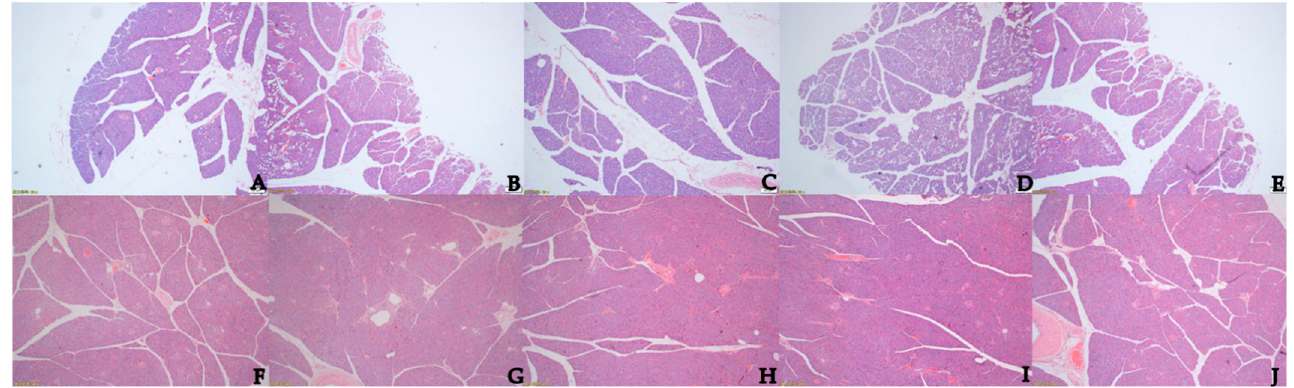
Figure 2. ( A – E ) Effect of no supplementation of concentrate on morphological development of pancreatic tissue in yak calves under 10 × microscope; ( F – J ) Effect of concentrate supplementation on morphological development of pancreatic tissue in yak calves under 10× microscope.